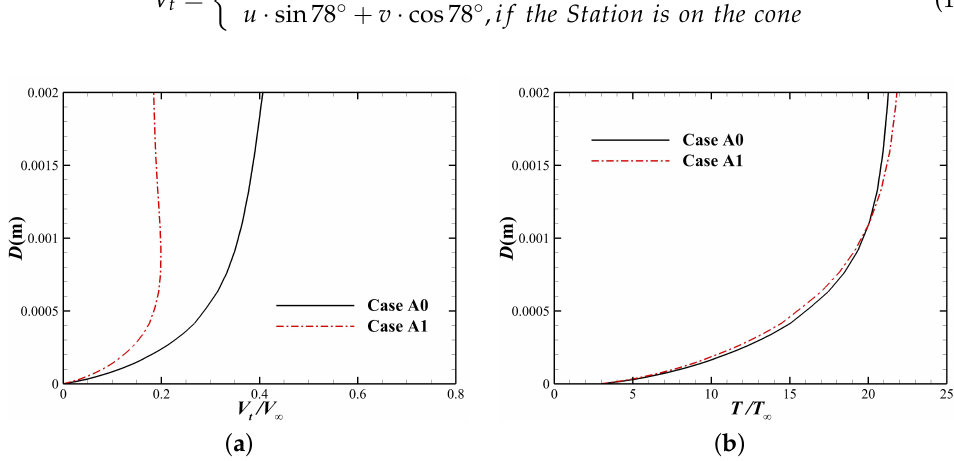
Figure 16. Boundary layer profiles at Station 1: ( a ) Tangential velocity. ( b )